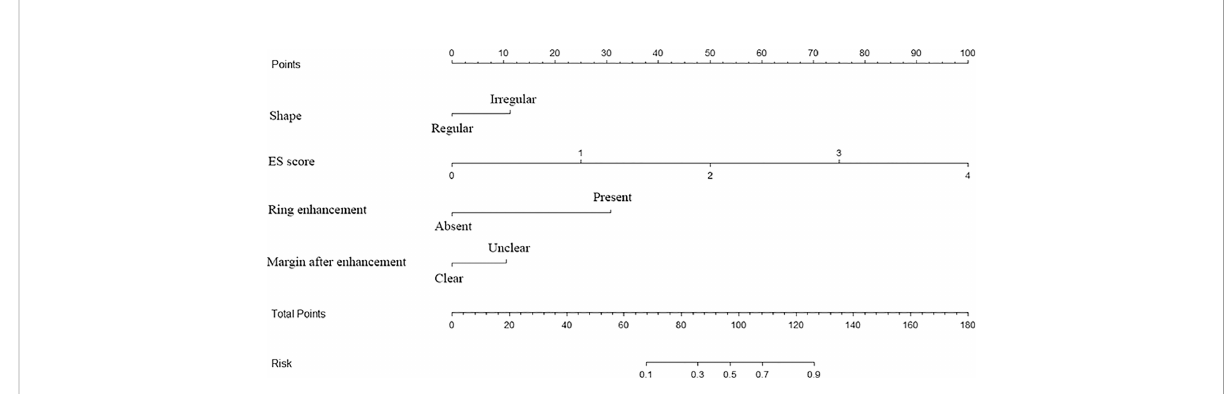
FIGURE 3 Multimodal ultrasonographic nomogram for predicting risk of thyroid cancer ES,